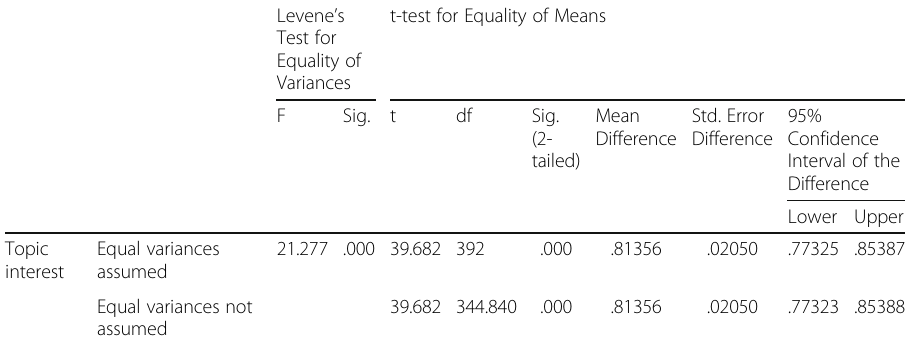
Table 8 The Results of T-Test to Compare the Results of Learners ’ Perception of Textbook- Assigned and Self-Selected Topics Regarding Topic